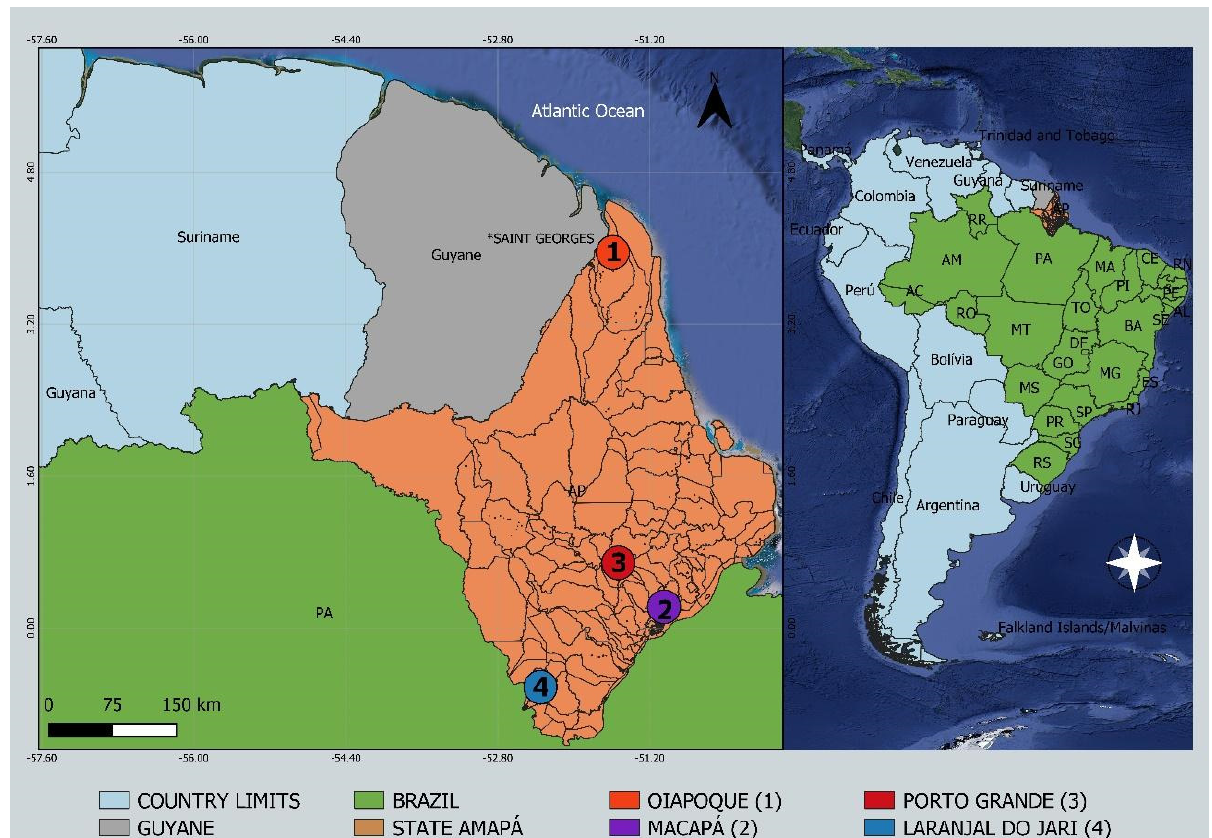
Figure 1. Study sites in the state of Amapá, northern Brazil, showing locations of sequenced cases of CHIKV-Asian outbreak. Circles indicate municipalities: (1) Oiapoque; (2) Macapá; (3) Porto Grande; (4) Laranjal do Jari.